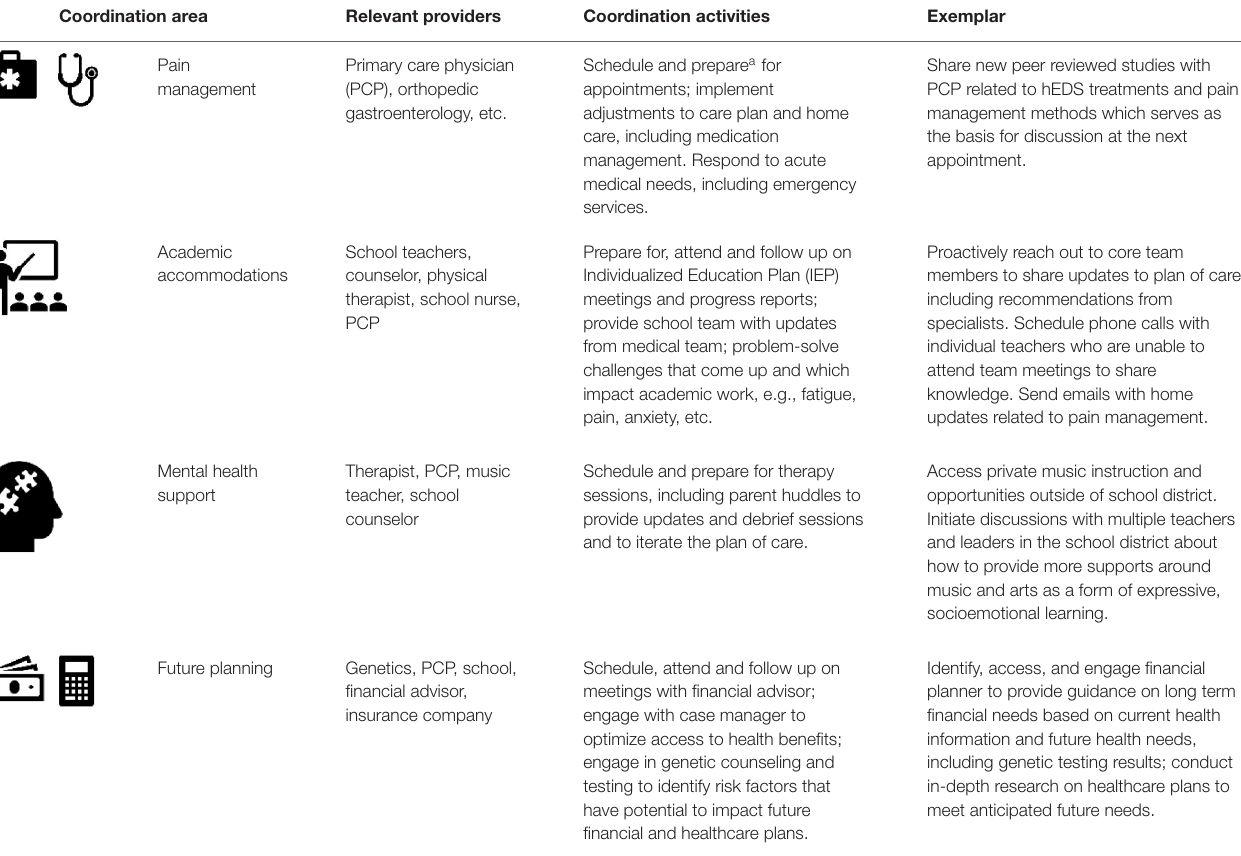
TABLE 2 | Coordination role of informal caregiver for a pediatric patient by coordination area: pain management, academic accommodations, mental health support, and future